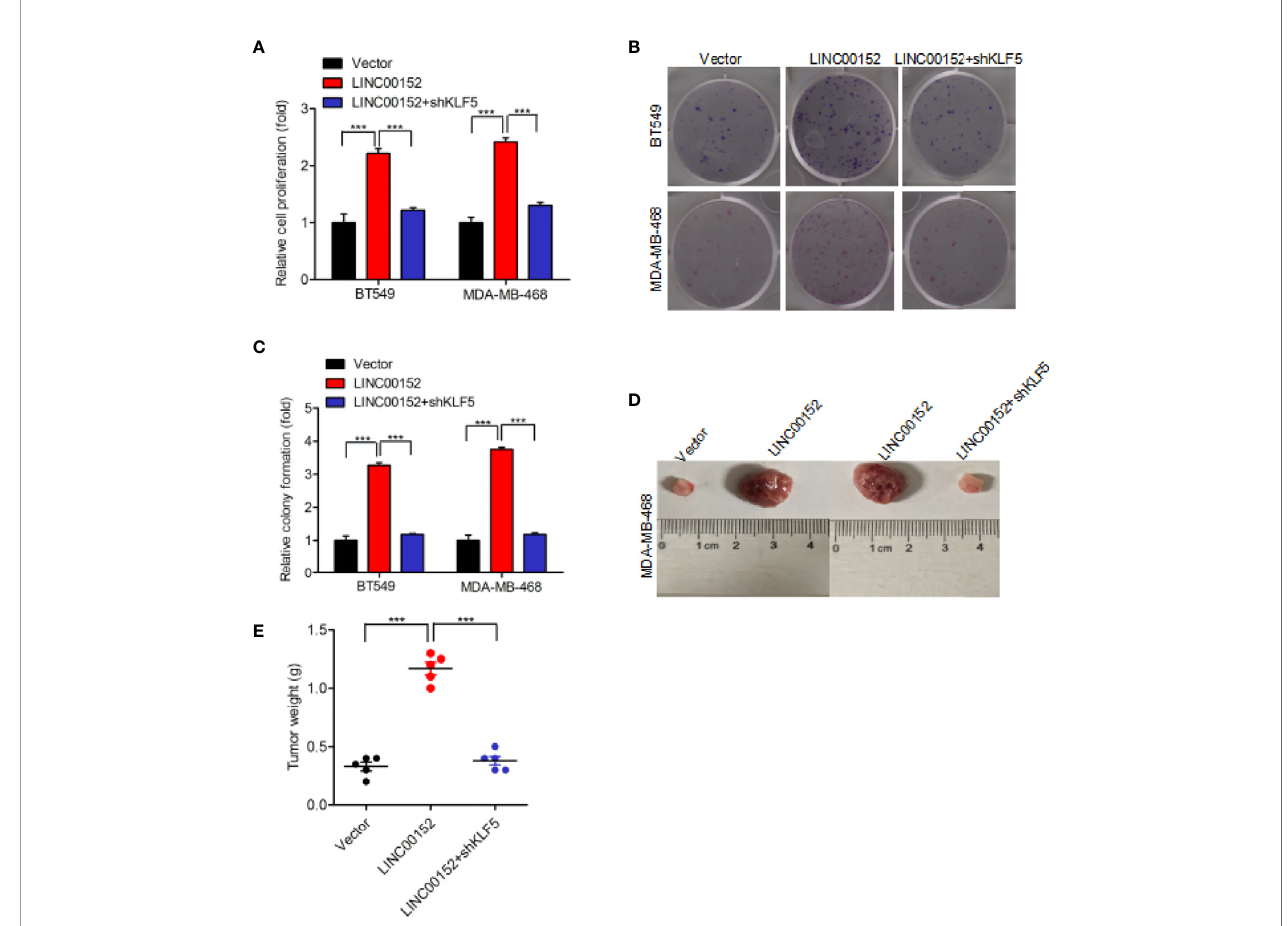
FIGURE 6 | LINC00152 promotes cell proliferation via KLF5 in breast cancer. (A, B) Knockdown of KLF5 restores LINC00152 overexpression-promoted cell proliferation (A) and colony formation (B) in BT549 and MDA-MB-486 cells. (C) Quanti fi cation of colony formation in (B) . (D) Representative images of LINC00152 overexpression or LINC00152 overexpression combined with KLF5 knockdown groups-infected MDA-MB-468 cells that were transduced when injected into nude mouse gland fat pads. Data were from three independent experiments with fi ve mice per group. (E) Quanti fi cation of tumor weight in (D) . ***P < 0.001. Error bars represent SD. Data are representative of three independent